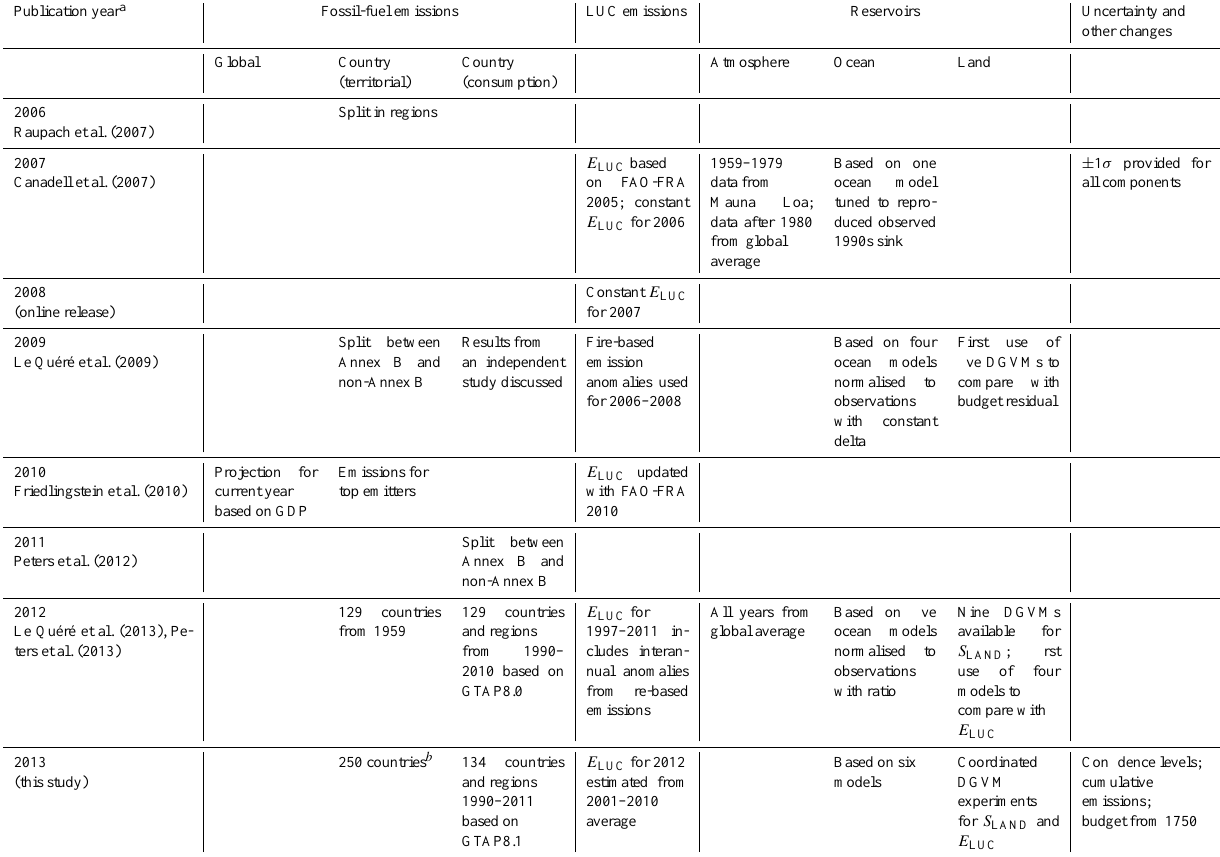
Table 3. Main methodological changes in the global carbon budget since first publication. Unless specified below, the methodology was identical to that described in the current paper. Furthermore, methodological changes introduced in one year are kept for the following years unless noted. Empty cells mean there were no methodological changes introduced that